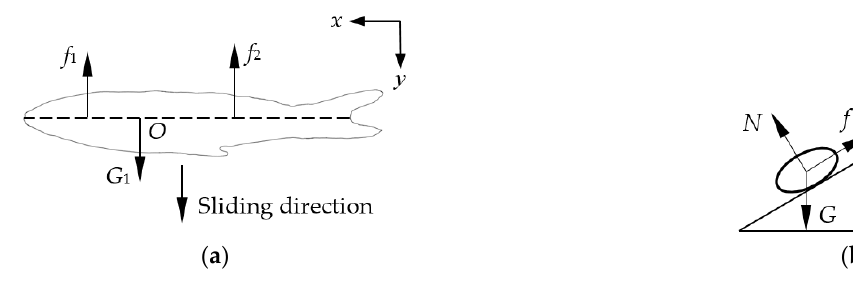
Figure 2. Diagram of the forces on the fish. ( a ) Force in x-y plane. ( b ) Force in y-z plane. In addition, the friction angle of the fish body with the scale direction is smaller than the friction angle of the anti-scale direction. Therefore, it is conducive to the stable sliding of the fish body on the slope of the trough after the head and tail are oriented. To slide more stably, the difference between the friction angle with the scale and the friction angle against the scale needs to be larger. In this research, silicone with bumps, a 316 L stainless steel plate and a PU conveyor belt were selected. It adopted the same measurement method as Wan et al. [6] to measure its friction angle, and the measurement results are shown in Table 1. Table 1. Friction angle measurement of fry.